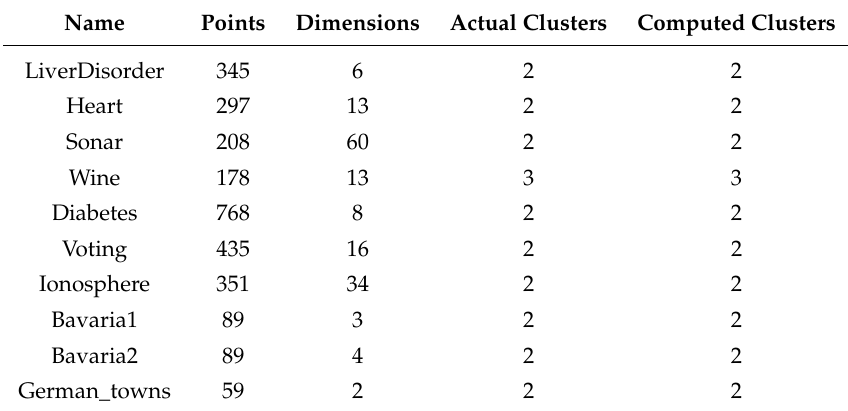
Table 5. Results of clustering in real world datasets with known classes.